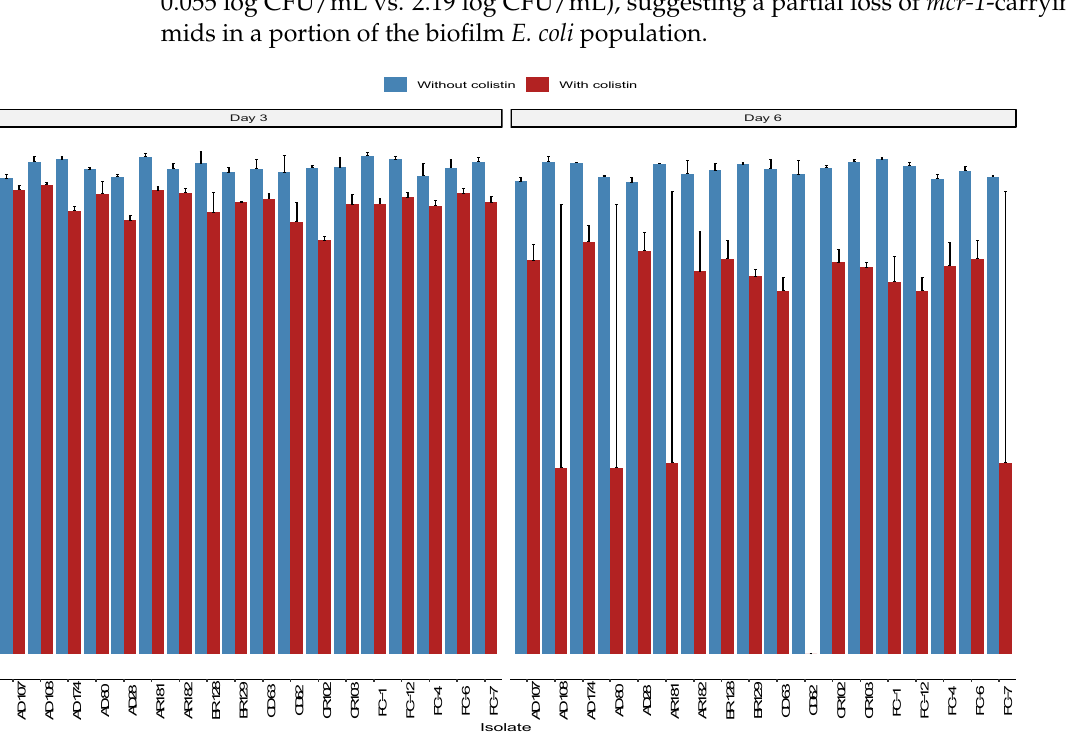
Figure 3. ( A ) Representative image of the trans-conjugant E. coli K12 growth in Muller–Hinton media supplemented with 2 µ g/mL of colistin and 2000 µ g/mL of streptomycin following conjugation. The negative control underwent the conjugation method without adding donor cells. ( B ) Agarose gel electrophoresis of the mcr-1 PCR product from DNA extracts of the transconjugants. The first well, labeled M, contains a 1 kb Ladder. mcr-1 positive E. coli isolates (donors) underwent conjugation with E. coli K12, strain IM93b (recipient). The origin of the DNA in each well were as follows, 1: ad28,